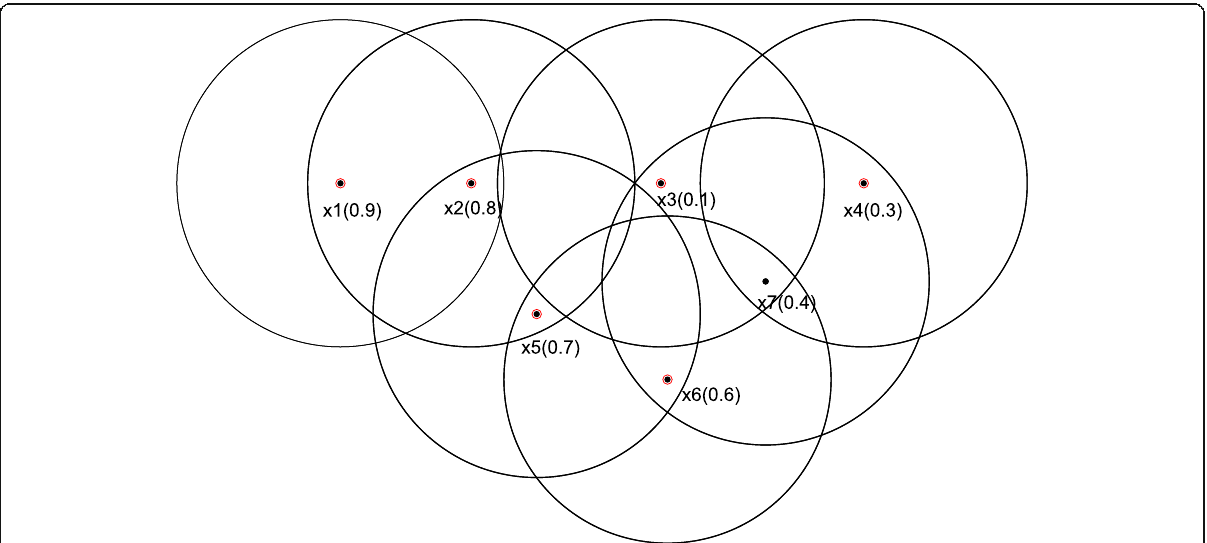
Fig. 2 Density overestimation in MHCP model. Nodes around red circle would be retained. The nodes x 3 and x 4 are retained for they have the lowest mark in their contention domain, and nodes x 1 , x 2 , and x 5 , x 6 are retained for they have the second lowest mark in their contention domains, while the corresponding nodes with the lowest mark ( x 2 , x 5 , x 6 , x 7 ) are not the one with the lowest mark in their contention domains. A reasonable scheme would retain x 3 , x 4 , x 1 , and x 5 or x 3 , x 4 , x 2 , and x